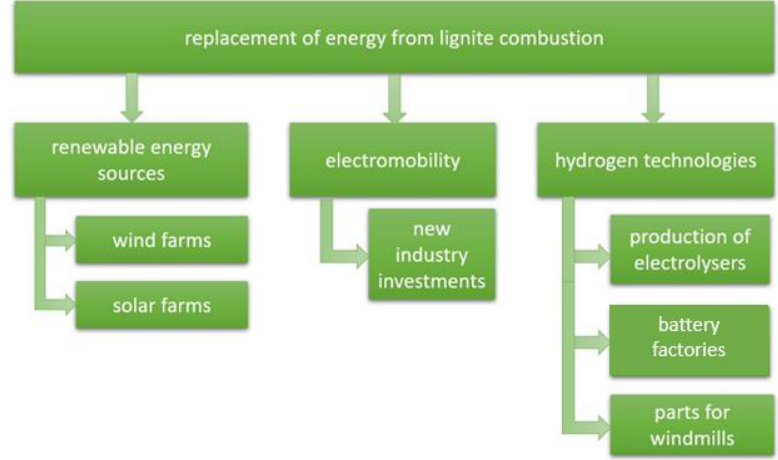
Figure 10. Replacement of energy from lignite combustion [69].